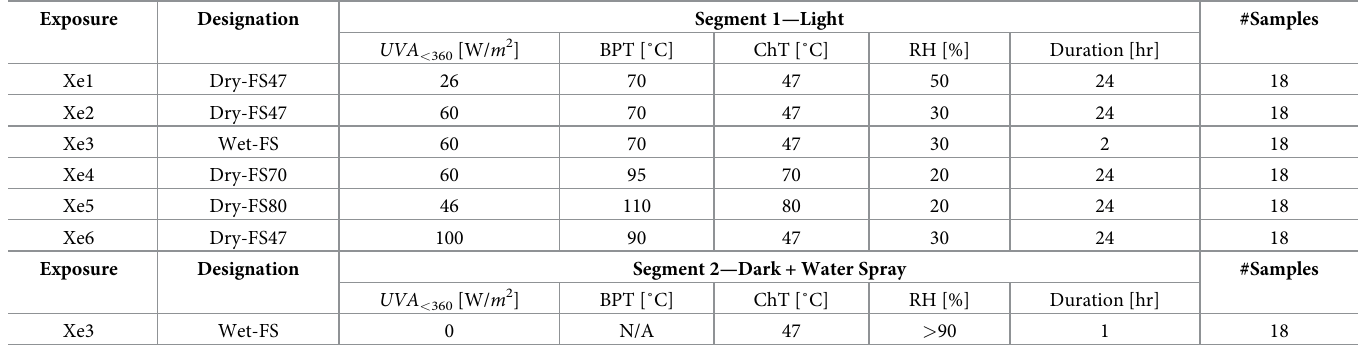
Table 5. Summary of the xenon-arc lamp exposure conditions. BPT is the black panel temperature. ChT is the chamber temperature. Xe3 is the only xenon-arc exposure that included a dark segment with water spray. Designations are classifiers used in modeling and cross-correlation. “#Samples” is the total number of samples under each exposure